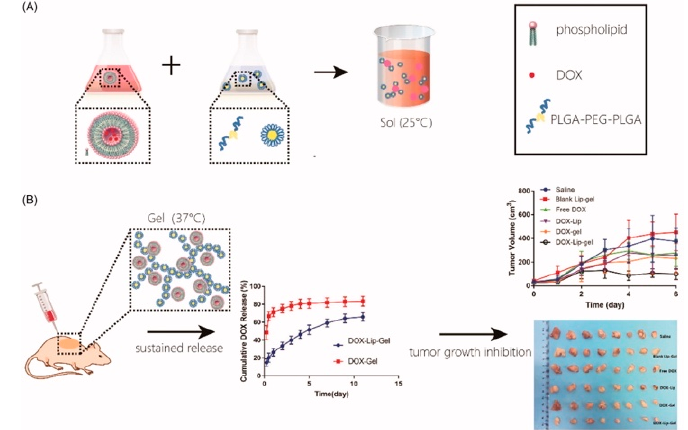
Figure 5. Schematic image of thermoresponsive hydrogels with vesicles/emulsomes: ( A ) a solution preparation method and ( B ) sustained release and tumor growth inhibition achieved by thermoresponsive hydrogels with vesicles/emulsomes. Reprinted from [38] ARTIFICIAL CELLS, NANOMEDICINE, AND BIOTECHNOLOGY, 47, Dinglingge Cao et al., Liposomal doxorubicin- loaded PLGA-PEG-PLGA based thermogel for sustained local drug delivery for the treatment of breast cancer, 181–191, Copyright (2019).